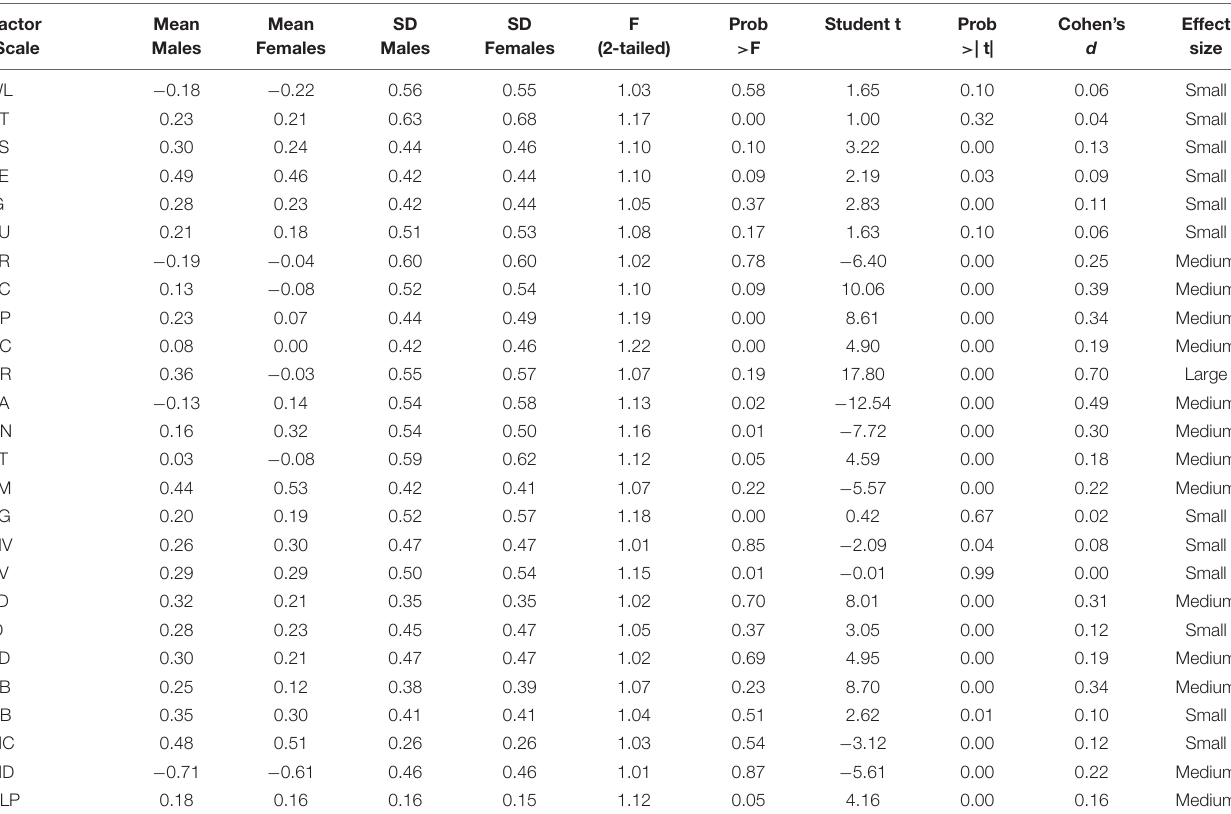
TABLE 3 | Gender comparison of MMP scale scores ( n Males =1,442; n Females =1,185). Factor /Scale